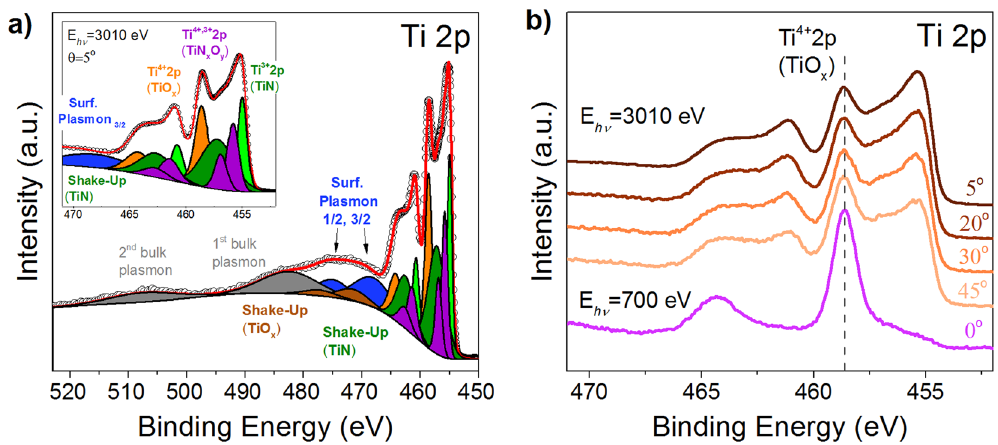
Figure 2. Experimental Ti2p photoelectron spectra collected from TiN/ γ -Al 2 O 3 /Si stack. Panel (a) shows the experimental and fitted spectrum measured at the excitation energy of 3010 eV and electron emission angle of 5°. The left hand inset is zooming in the main part of the spectrum. Panel (b) shows the spectra measured at excitation energy of 3010 eV and electron emission angles of 5°, 20°, 30° and 45° and the spectrum measured at the excitation energy of 700 eV and normal emission. All spectra in panel (b) are normalized to the background providing the same intensity and are shifted along the ordinate for